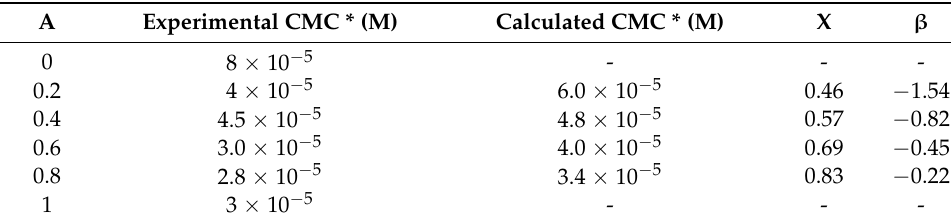
Table 1. The micellization parameters in binary mixtures Cremophor EL and Pluronic F127 in various molar ratio obtained from the Rubingh model.